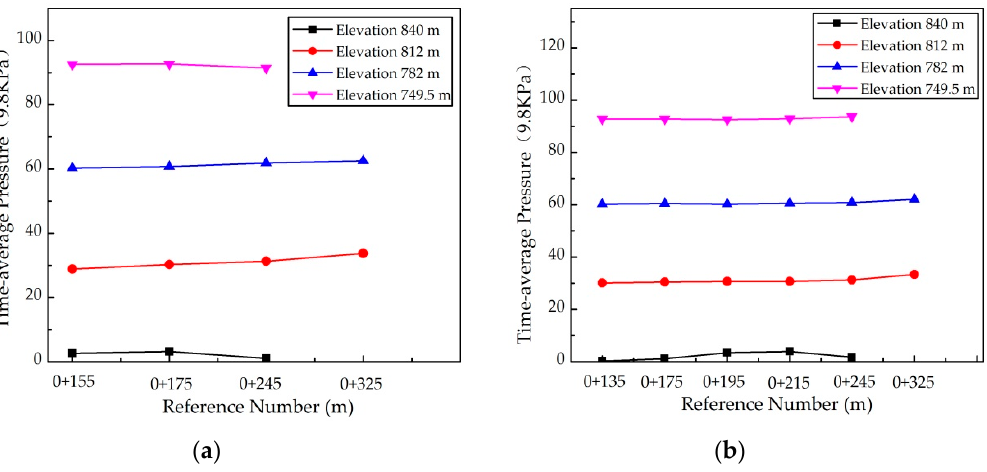
Figure 7. Time-average pressures on the slope lining plates under operating Condition 2. ( a ) left slope; and ( b ) right slope.